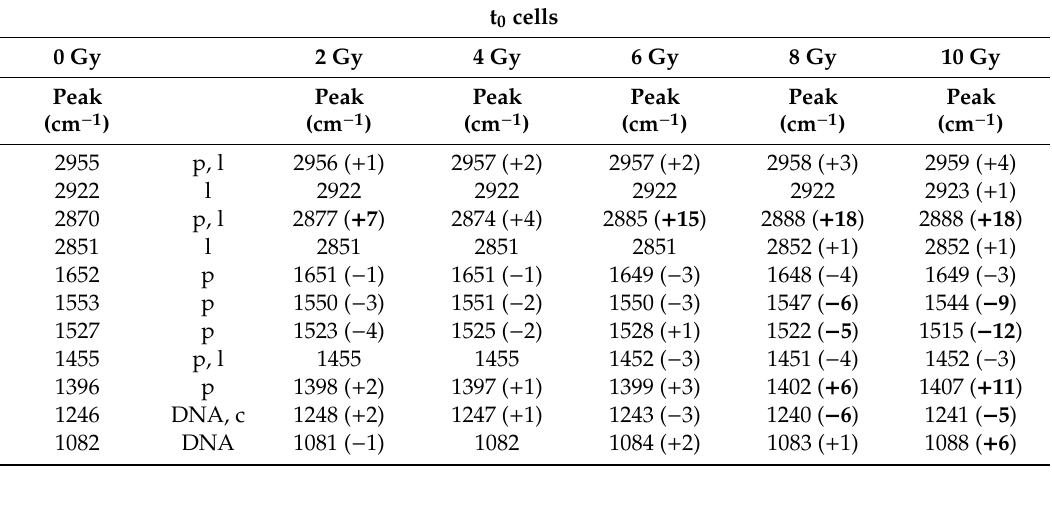
Table 2. Average FTIR peaks position for control and samples treated with di ff erent dose of X-rays fixed immediately after irradiation. The shifts in terms of units of wavenumber are indicated in brackets (bold values stand for shifts greater than the spectral resolution of the instrument 4 cm − 1 ). Abbreviations: p = proteins, l = lipids, c = carbohydrates.